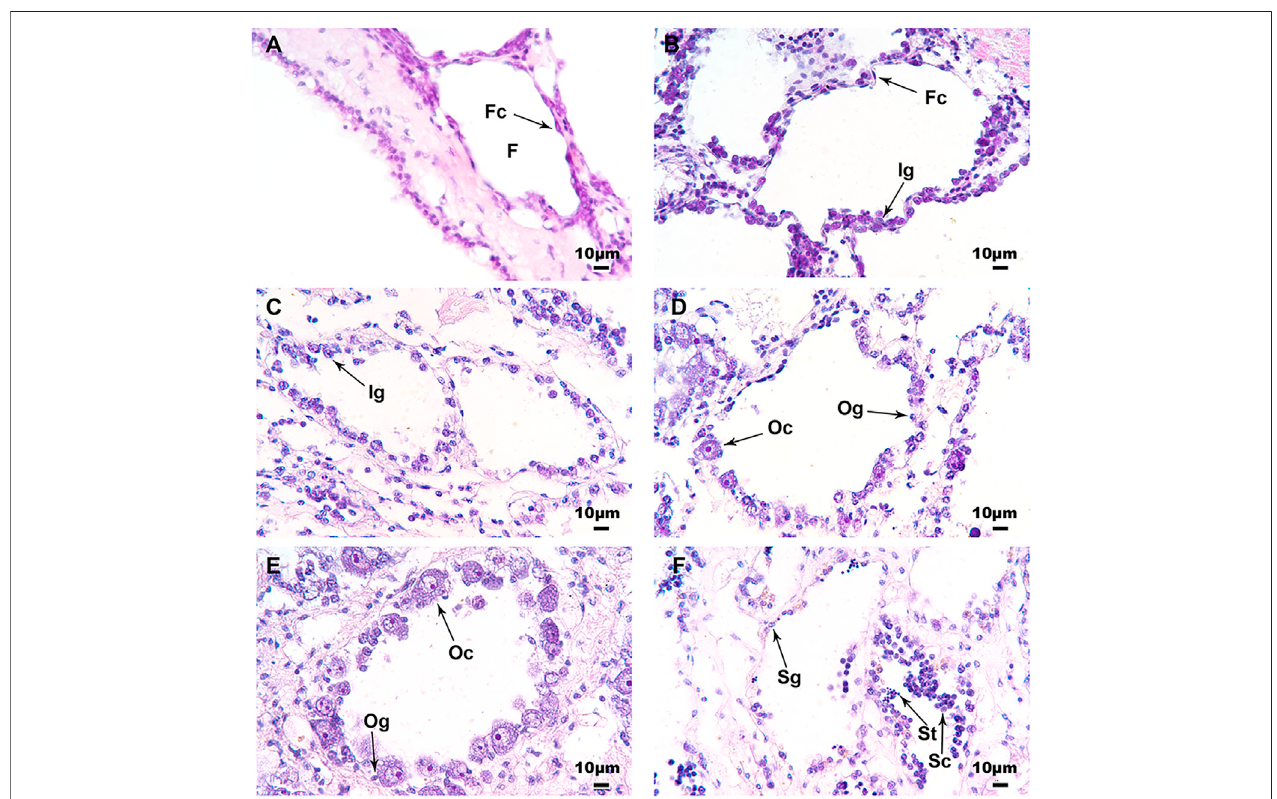
FIGURE 3 | Histological observations of the juvenile gonads on day 0 and 50 at three different temperatures. (A) Undifferentiated gonad of a 6 month-old juvenile scallop on day 0; (B) Gonad from the 21 ° C group on day 50; (C) Undifferentiated gonad from the 16 ° C group on day 50; (D) Ovary from the 16 ° C group on day 50; (E) Ovary from the 11 ° C group on day 50; (F) Testis from the 11 ° C group on day 50. Six scallops were sampled for histological analysis at each stage. F, follicle; Fc, follicle cell; Ig, indistinguishable gonium; Og, oogonium; Oc, oocyte; Sg, spermatogonium; Sc, spermatocyte; St, spermatid.